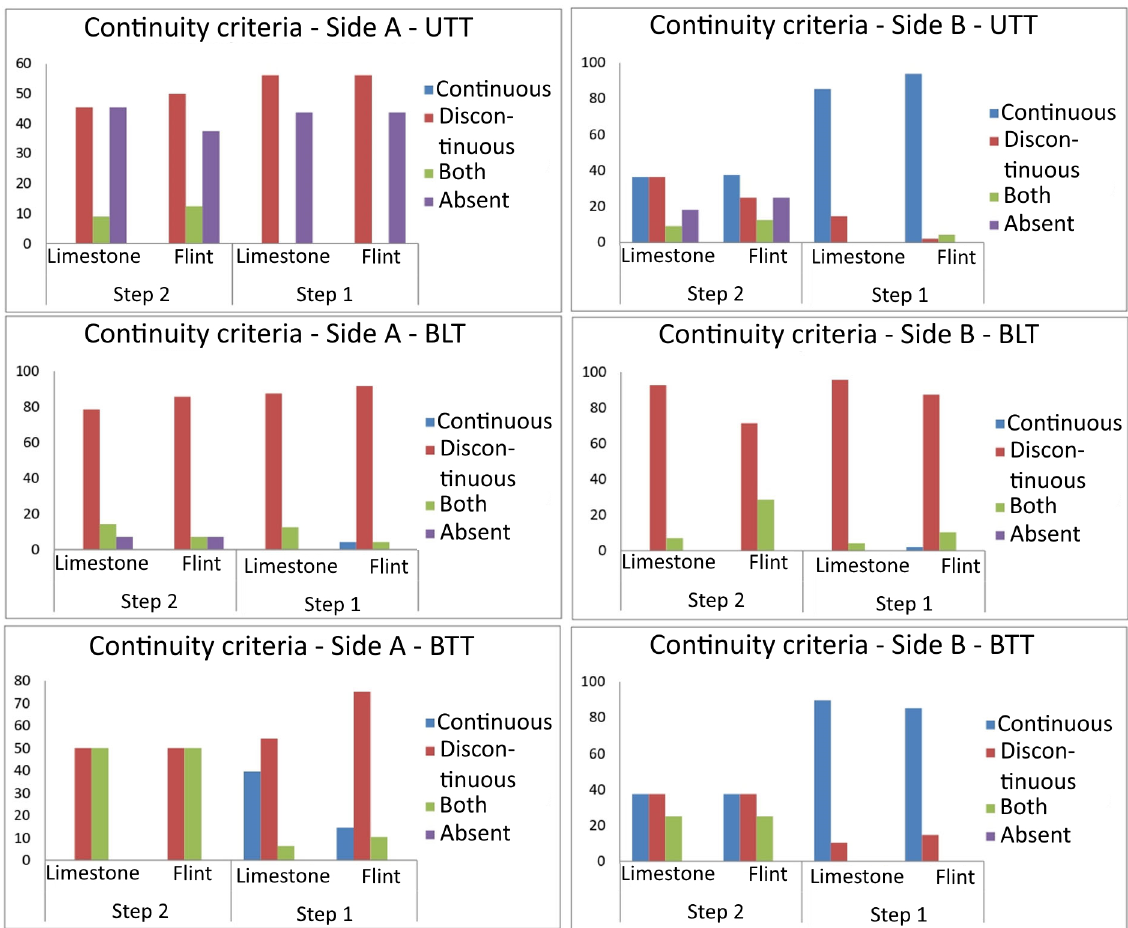
Figure12. Comparison to experimental step 1 and 2, for the distribution